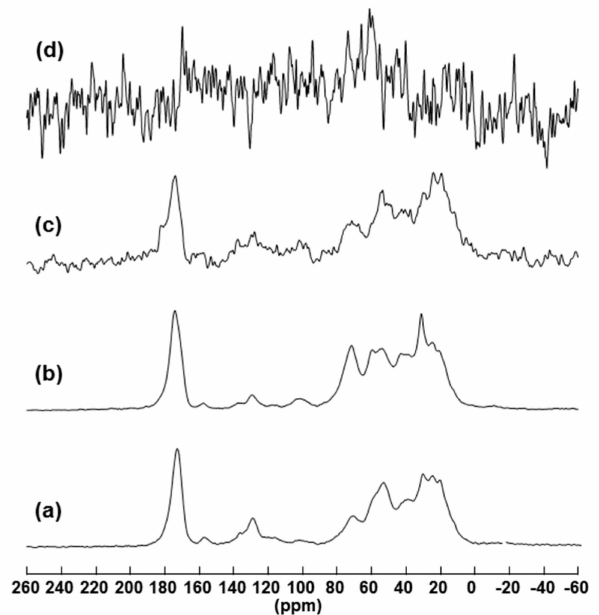
Figure 4. The 13 C Cross-Polarization (CP)-Magic Angle Spinning (MAS) NMR spectra of the four samples: ( a ) PETRO (number of scans = 79,200); ( b ) GEODIA (number of scans = 113,203); ( c ) APHRO (number of scans = 98,320); and ( d ) LAOCO (number of scans = 171,580). For all spectra, the 1 H– 13 C contact time was 1 ms and the recycling delay was 2